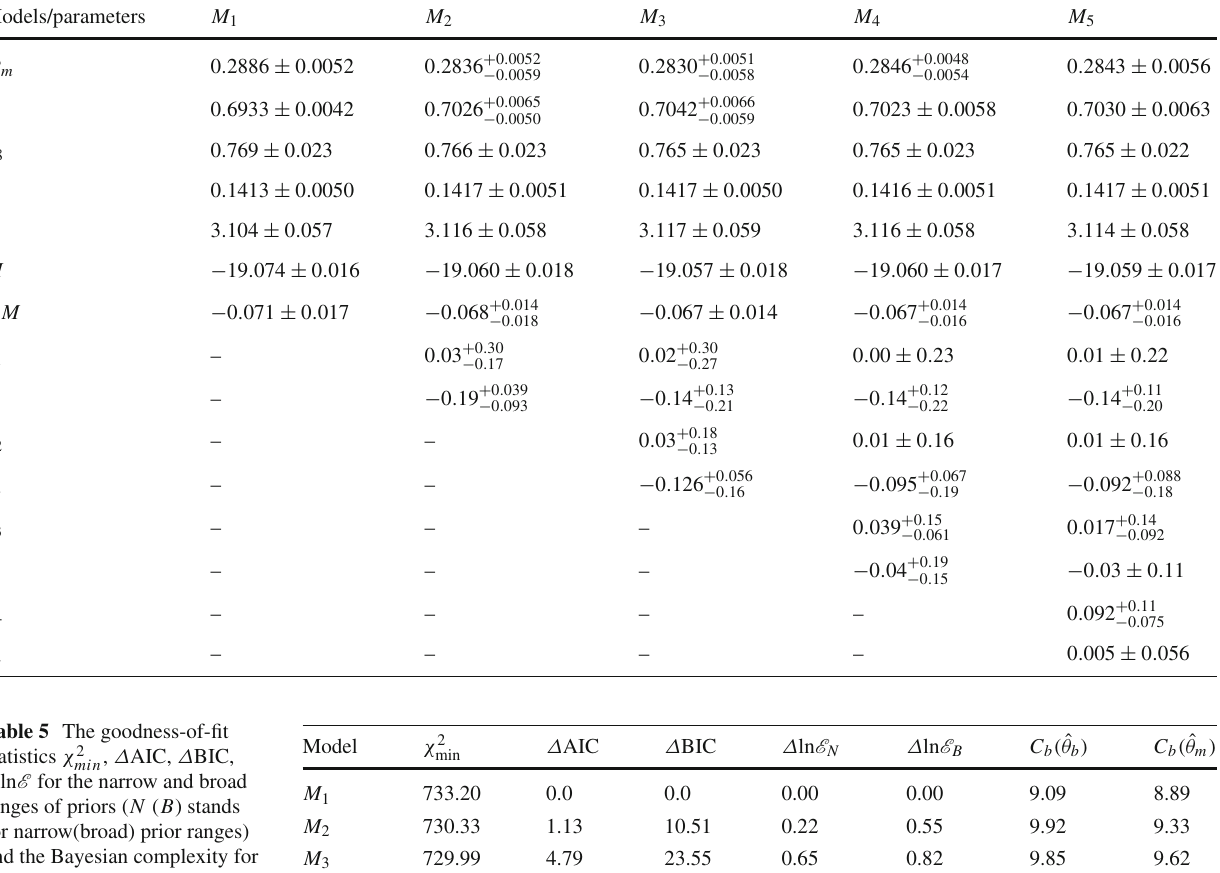
Table 4 The best-fit values and the corresponding 1 σ uncertainties for the current Padé parametrizations. Notice that the Λ CDM model can be seen as a Padé M 1 parametrization, namely b i = c i = 0 Models/parameters